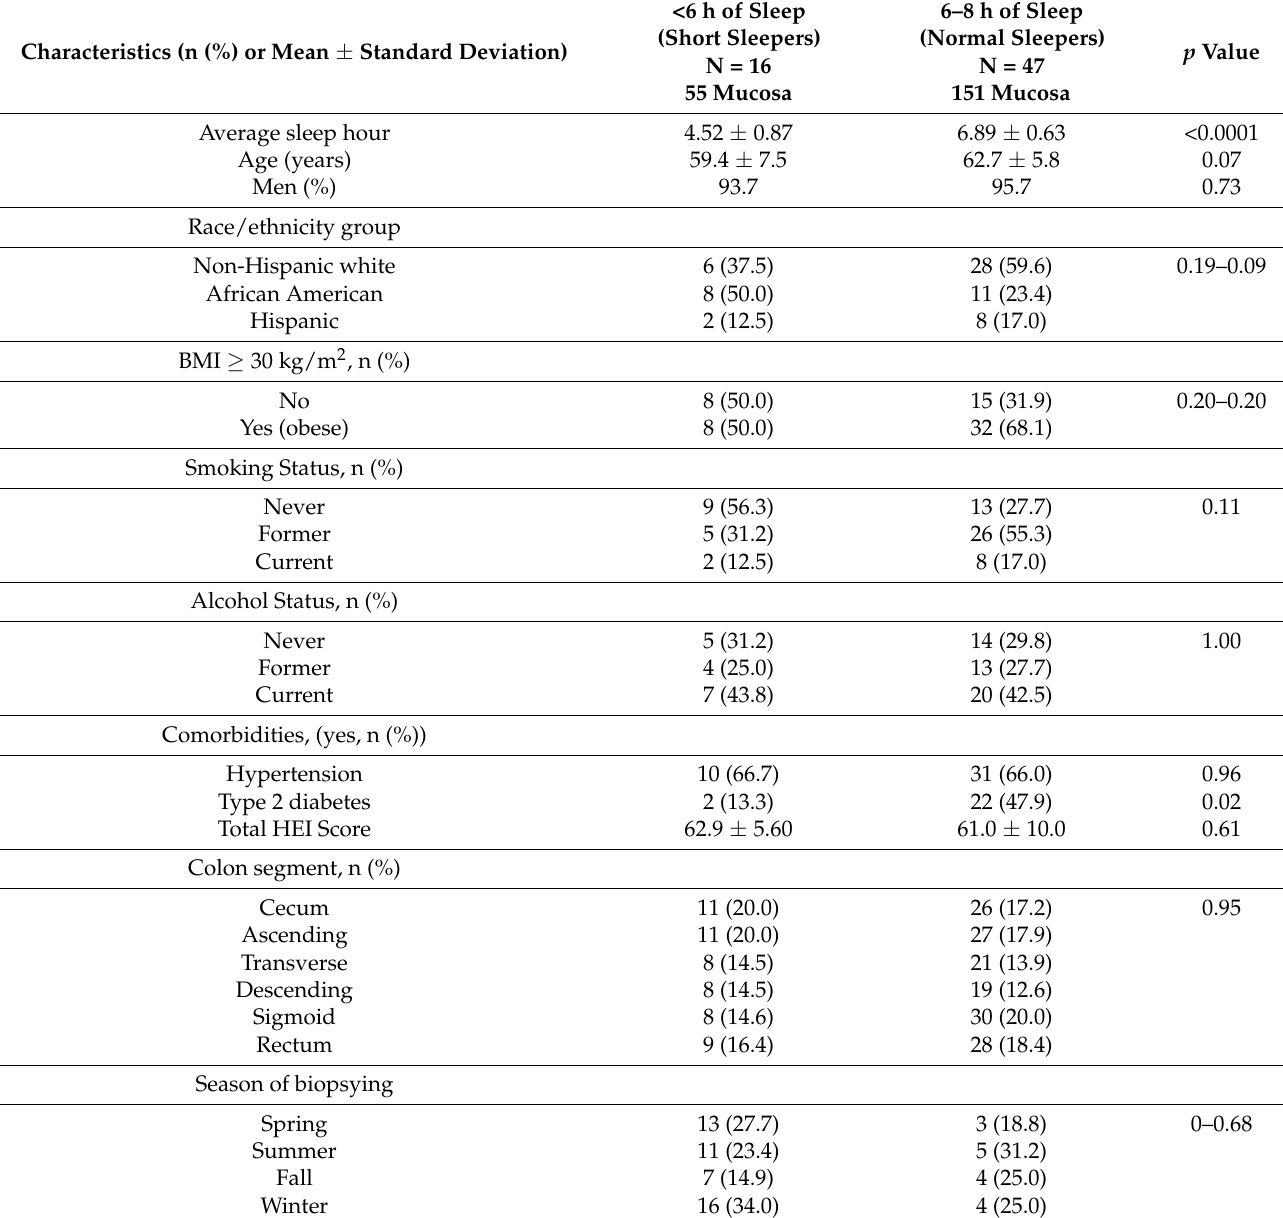
Table 1. Basic characteristics of the participants based on sleep hours per